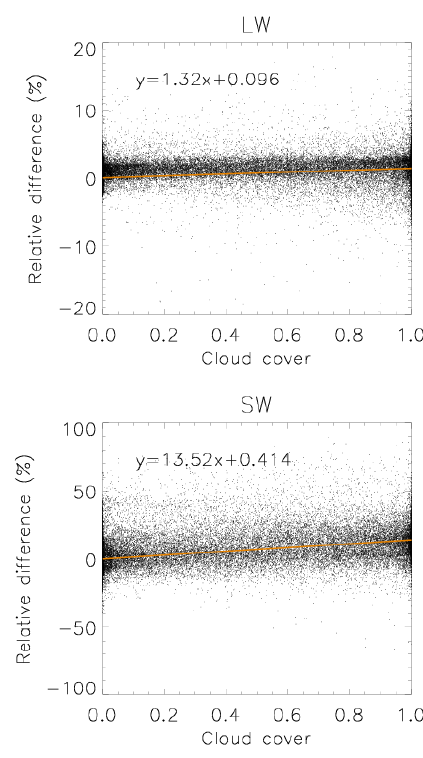
Fig. 12. Dependence of the CERES and RRUMS relative difference on cloud cover.